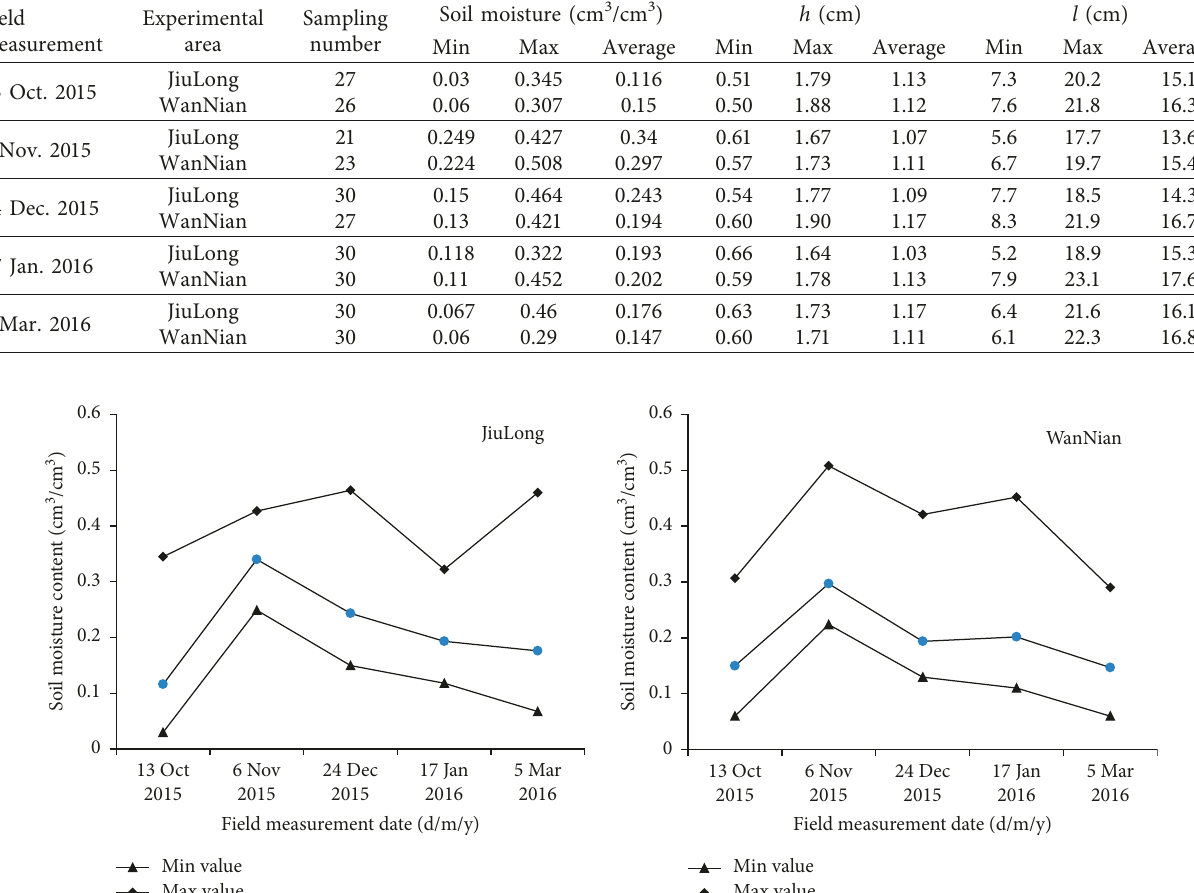
Table 3: The statistics results of the field measurements over the study area.